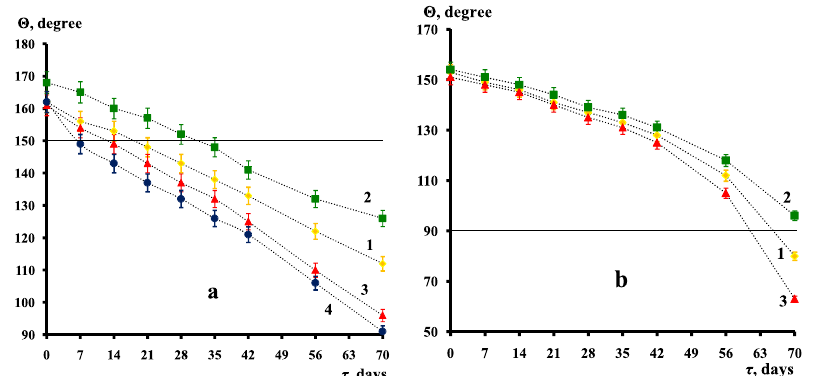
Figure 2. Change in the contact angle Θ c on samples of alloy 6063 versus the time of holding the samples in distilled water, preliminarily subjected to LP ( 1 — LP-1; 2 — LP-2; 3 — LP-4) or etched in a 10% solution of NaOH ( 4 ), and then modified in an ethanol solution containing 1 mmol · L − 1 ODPA ( a ) and 10 mmol · L − 1 SA ( b ).